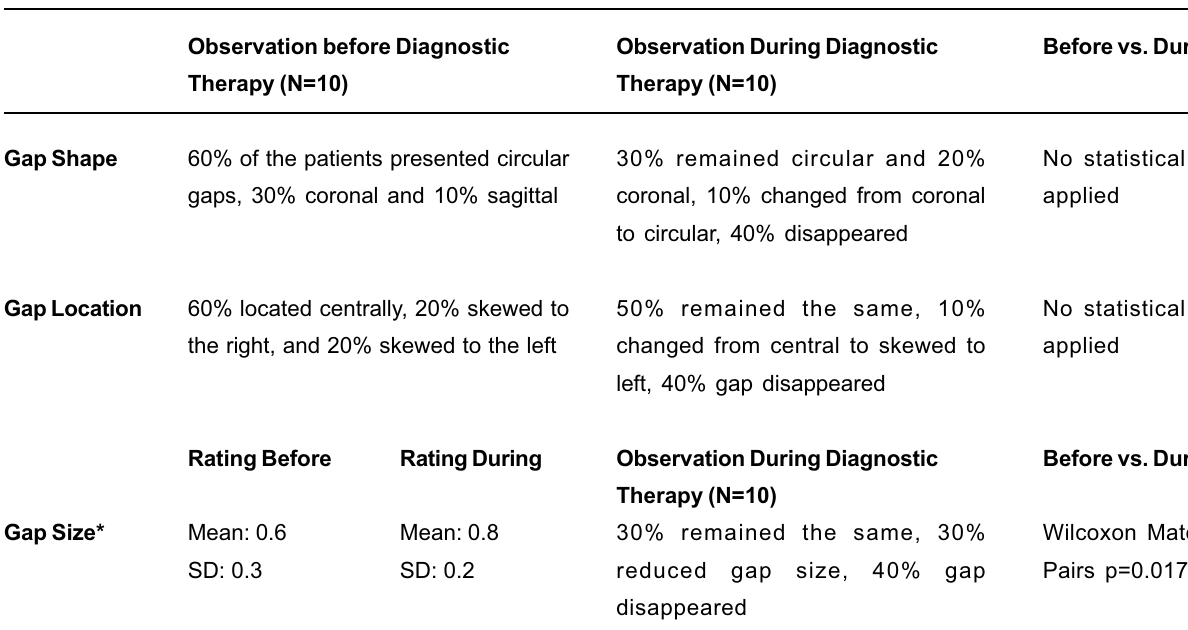
*Significant difference between displacement before and during diagnostic therapy